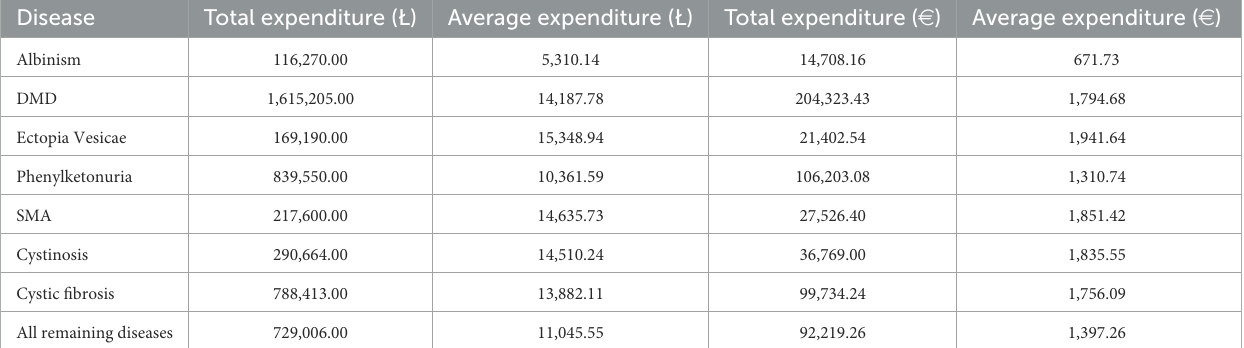
TABLE 4 Out-of-pocket healthcare expenditures based on disease. Disease